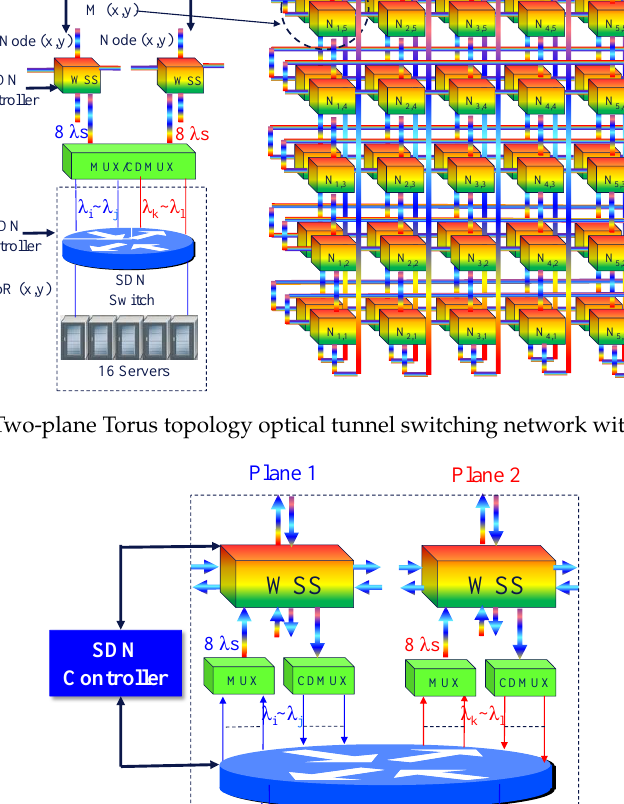
Figure 3. A module of multi-plane Torus topology optical tunnel switching network.